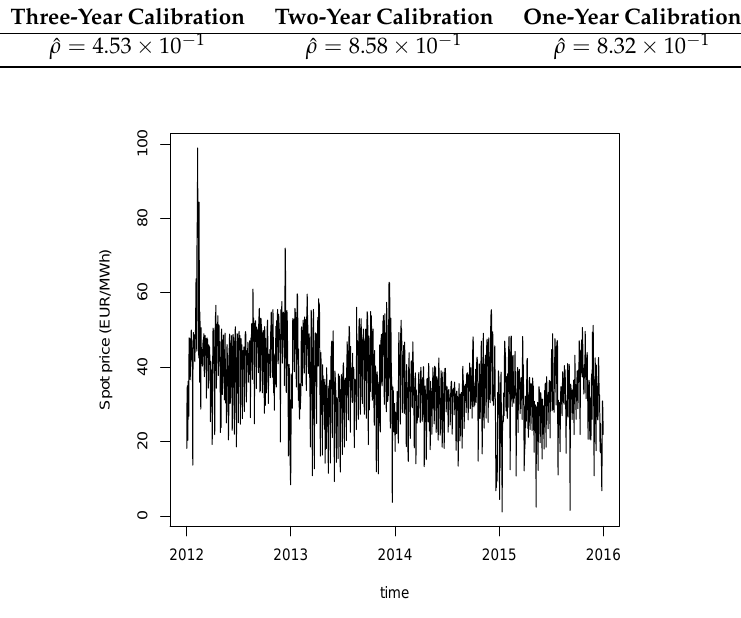
Table 6. Correlations estimated in the three different settings.